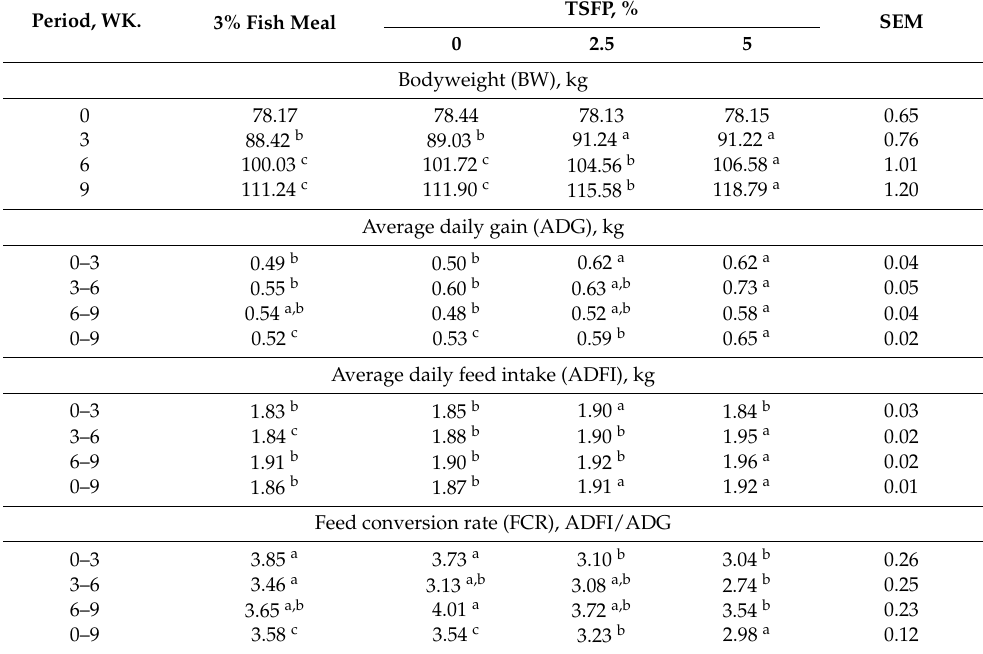
Table 4. Effects of TSFP on growth performance of finishing pigs.